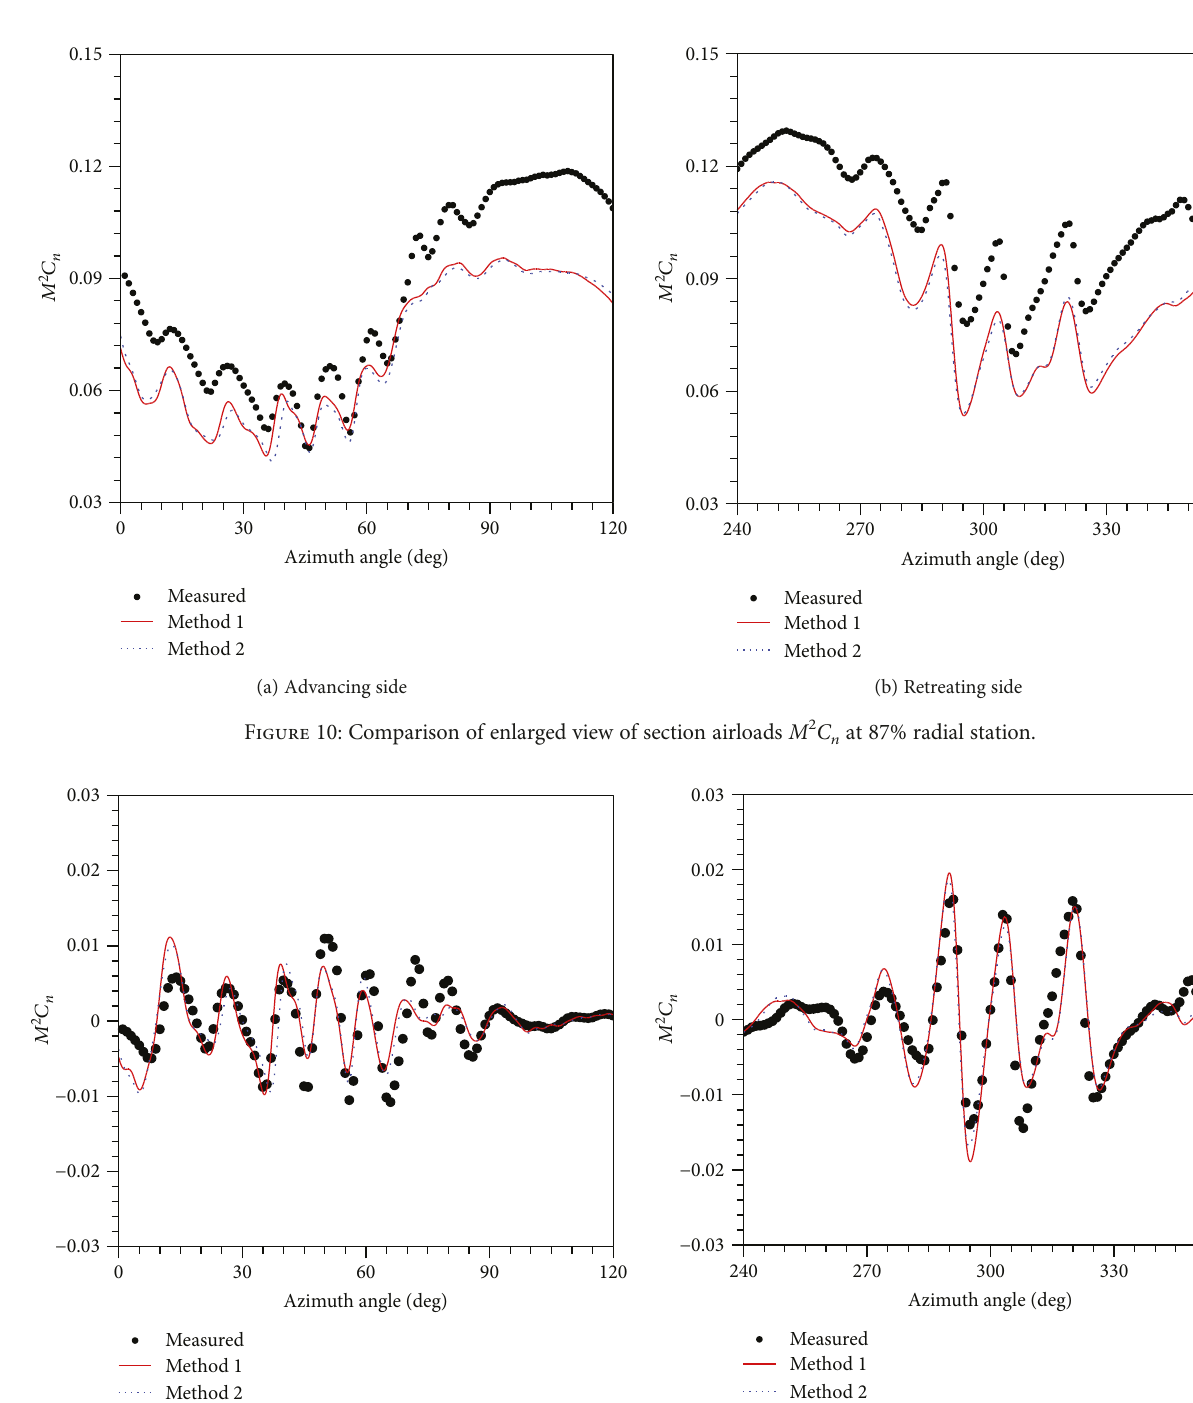
at 87% radial station. n